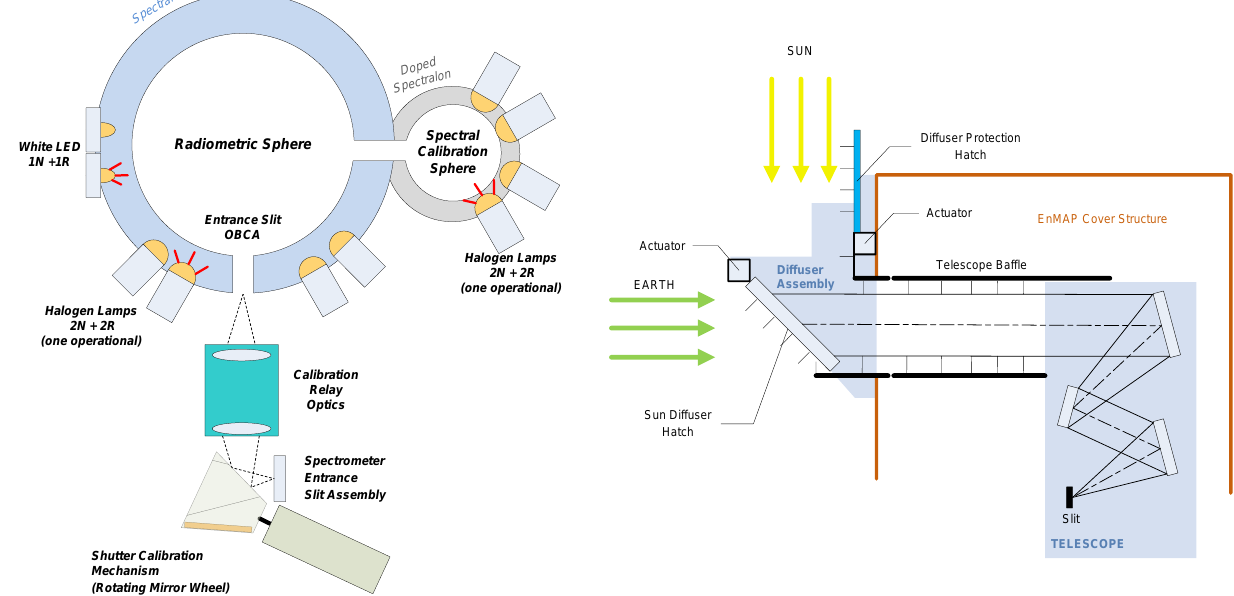
Figure 7. On-board calibration units of the EnMAP instrument. For spectral and relative radiometric calibration, the Ulbricht integrating sphere ( left ) provides a homogeneous source of illumination for the spectrometer entrance slits via coupling optics and a mechanism that introduces a mirror into the telescope beam. Absolute radiometric calibration is performed by using the Sun to illuminate the entrance pupil of the telescope via a Spectralon full-aperture diffuser ( right